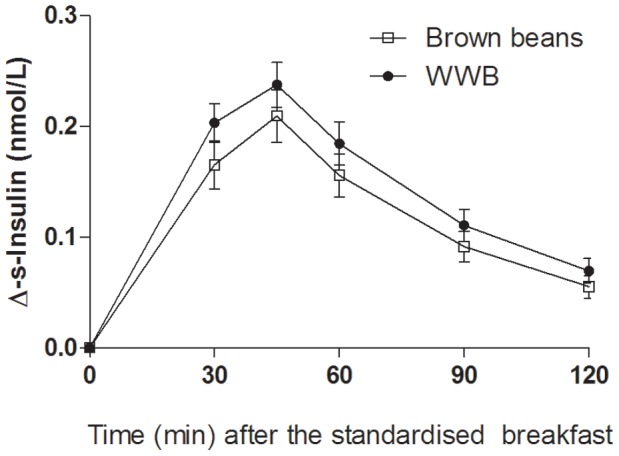
Mean incremental changes (Δ) in serum insulin concentrations after the standardized breakfast consumed 11 hours after evening meals composed of brown beans or WWB.A significant treatment (type of evening meal) effect was found over the test period (p<0.05, PROC MIXED in SAS release 9.2; SAS Institute Inc, Cary, NC). n = 16 subjects.